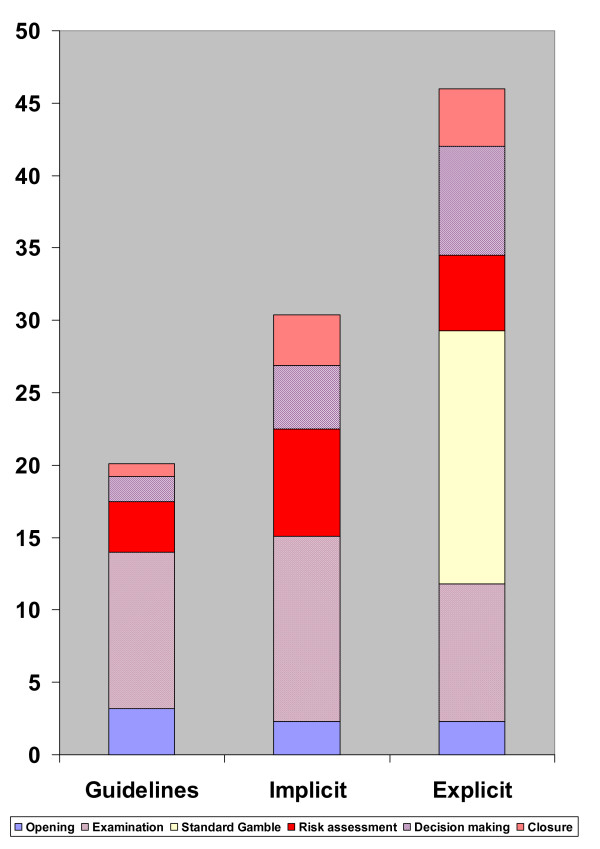
Median duration of the different phases of the consultation shown in minutes.